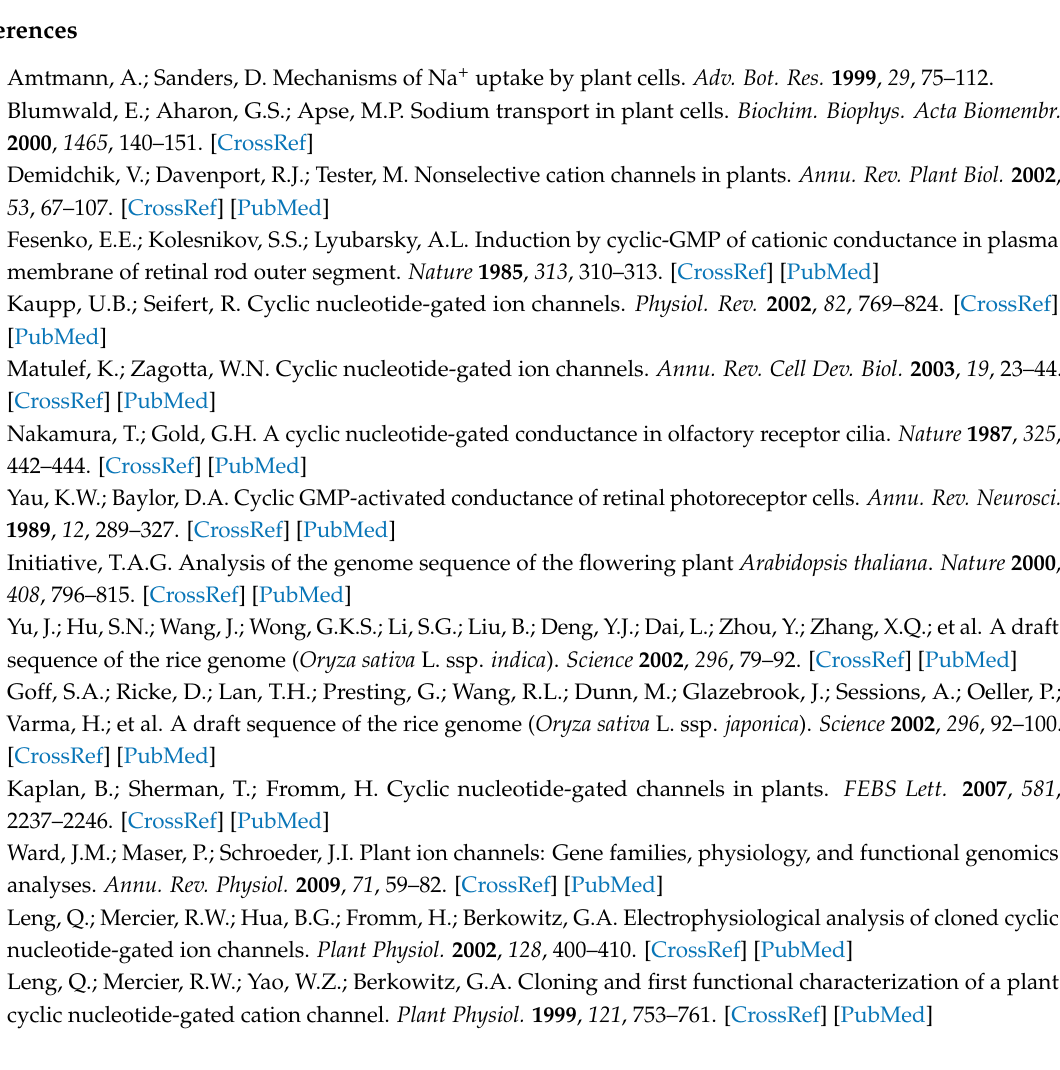
Table S1: Accession number of nucleotide sequence and peptide sequence of barley CNGCs, Table S2: Gene names of Arabidopsis CNGCs and their Arabidopsis Genome Initiative (AGI) code, Table S3: Comparison of deduced ion selective motifs and S4 domains in CNG and HCN channels in human and group II CNGC in barley, Figure S1: Current/voltage relationship of HvCNGC2-3 expressing oocytes in the presence of 8Br-cGMP, Figure S2: Current/voltage relationship of water-injected oocytes, Figure S3: Effects of substitution of Na + and K + on the current of HvCNGC2-3 cRNA-injected oocyte, Figure S4: Putative ion-selective pore-forming motifs of representative group II CNGCs of glasses, Figure S5: Secondary structure prediction of the cyclic nucleotide binding